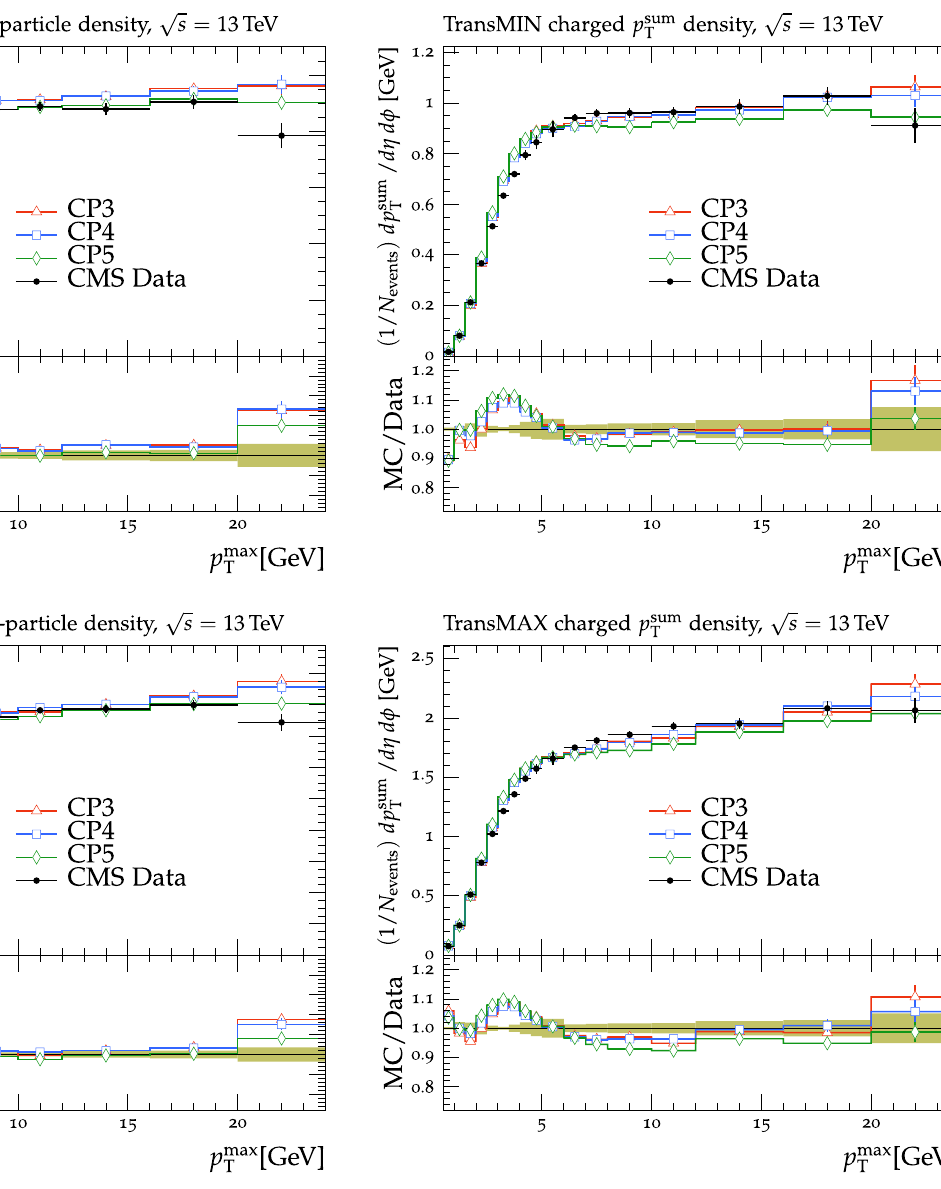
pythia 8 (N)NLO-PDF tunes CP3, CP4, and CP5. The ratios of simu- Fig. 5 The transMIN (upper left) charged-particle and charged p sum T lations to the data (MC/Data) are also shown, where the shaded band (upper right) densities and the transMAX (lower left) charged-particle indicates the total experimental uncertainty in the data. Vertical lines and charged p sum (lower right) densities, as a function of the trans- T drawn on the data points refer to the total uncertainty in the data. Ver- verse momentum of the leading charged particle, p max , from the CMS √ T s = 13TeV analysis [16]. Charged hadrons are measured with tical lines drawn on the MC points refer to the statistical uncertainty in p T > 0 . 5GeV in | η | < 2 . 0. The data are compared with the CMS the predictions. Horizontal bars indicate the associated bin